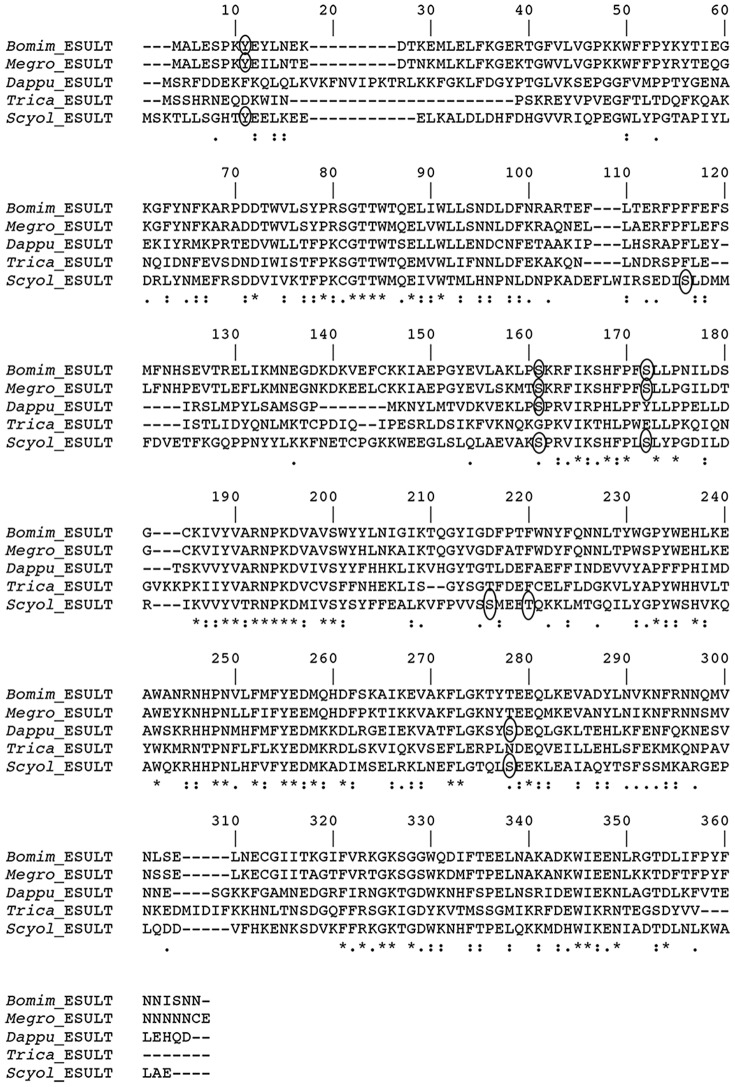
Alignment of S. olivacea amino acid sequence of estrogen sulfotransferase (ESULT) with similar sequence from other species.Gaps (-) included to allow for alignment. “*”: identical amino acids; “:”: conserved substitutions (same group); “.”: semi-conserved substitution (similar shapes). Circles indicating phosphorylation site prediction on protein sequences. (Scyol, Scylla olivacea), orange mud crab; (Trica, Tribolium castaneum), beetle (Accession number EFA11828); (Dappu, Daphnia pulex), water flea (EFX82151.1); (Megro, Megachile rotundata), leafcutter bee (XP_003706084); and (Bomim, Bombus impatiens), bumble bee (XP_003485365).